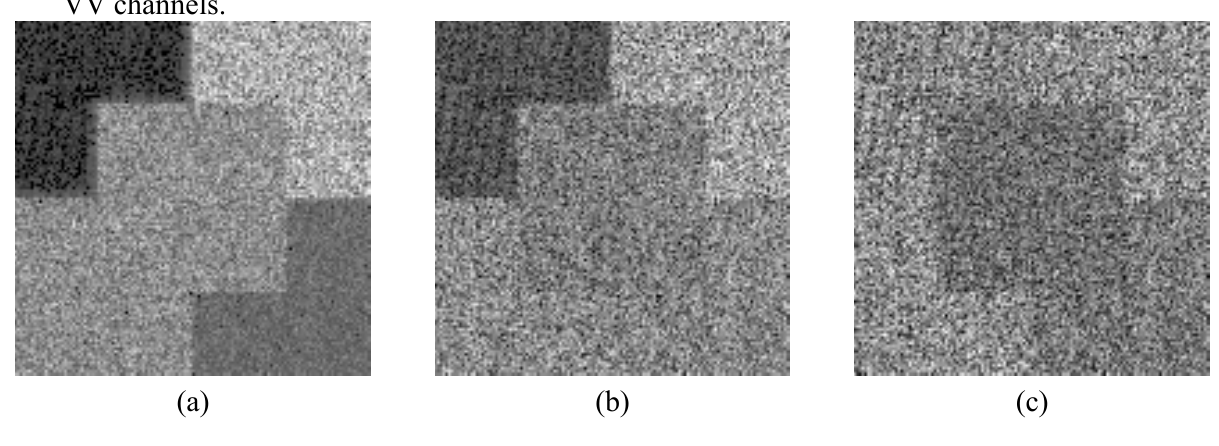
Figure 8. L-band amplitude simulated polarimetric SAR images: (a) HH, (b) HV and (c) VV channels.